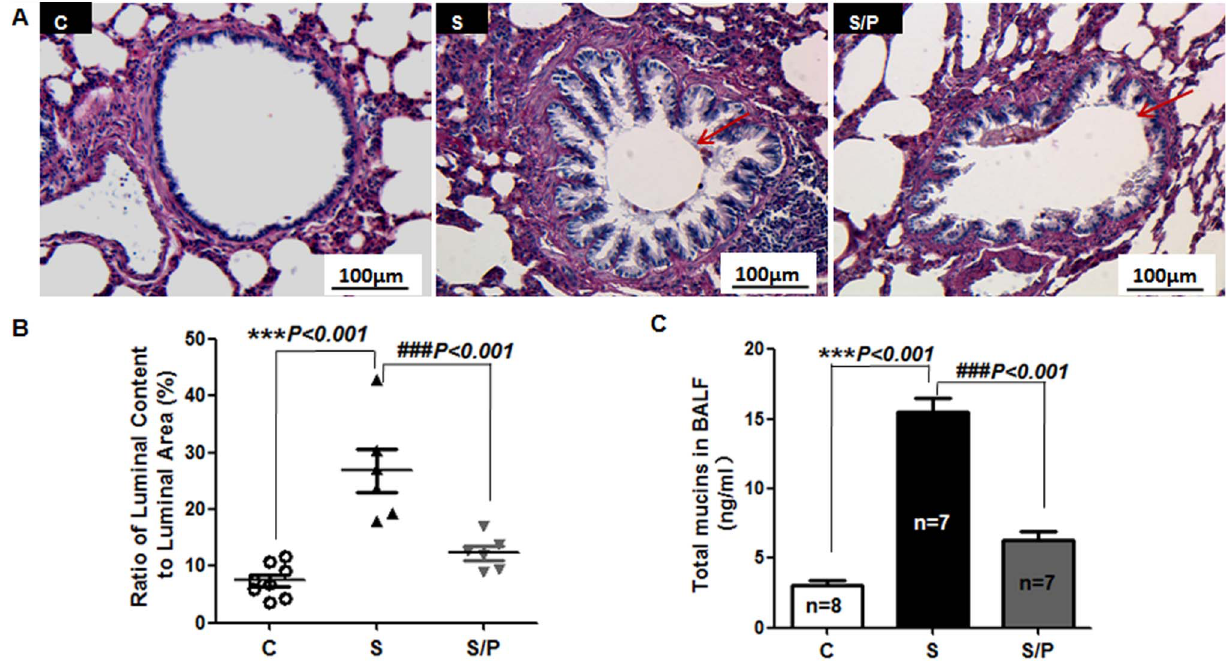
Figure 6. Chronic administration of propranolol attenuates airway mucus obstruction in rats exposed to CS. (A) Representative rat lung sections stained with periodic acid-Schiff exposed to air and vehicle (Group C), CS-exposed rats with vehicle (Group S) or prapronolol for 4 weeks (Group S/P). Scale bar, 200 m m. (B) Quantification of the area of airway lumen and luminal content of airways # 2 mm in diameter. (C) ELISA of total mucins in bronchoalveolar fluid (BALF). Data are mean 6 SEM. *** P , 0.001, compared with Group C; ### P , 0.001 compared with Group S.